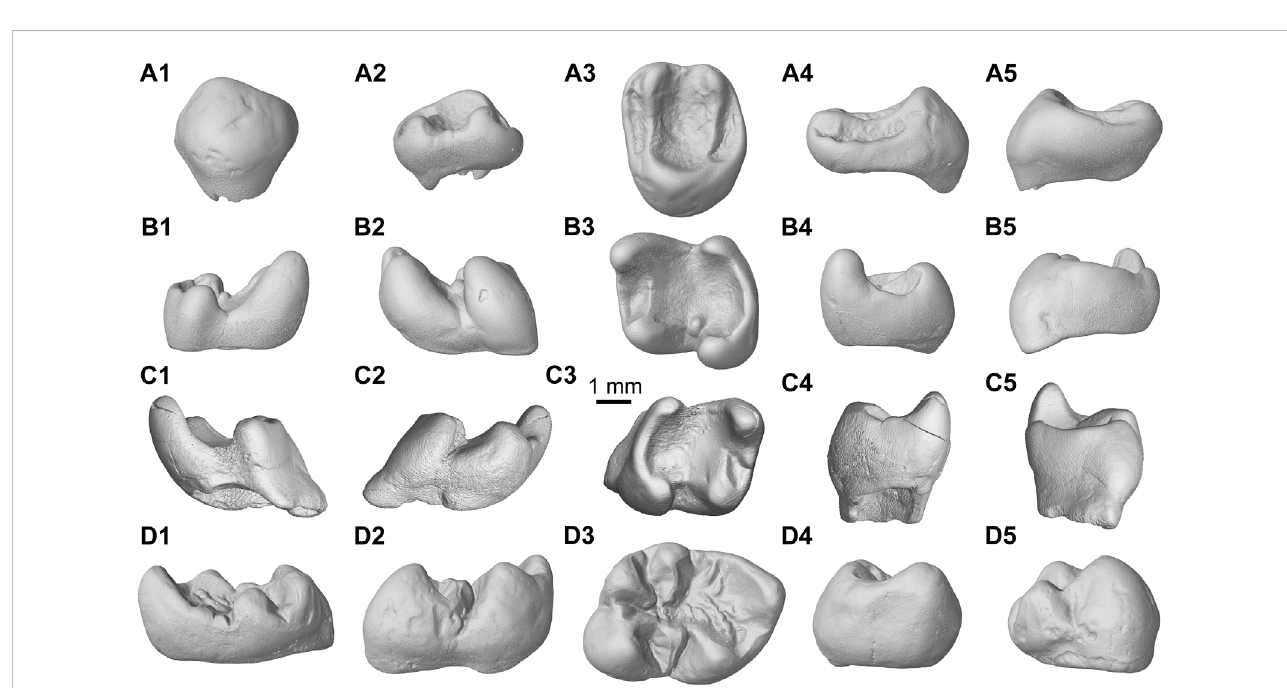
FIGURE 3 3D virtual reconstruction of the molars of Junggarisciurus jeminaiensis gen. et. sp. nov. and Eopetes irtyshensis gen. et. sp. nov. (A1 – A5) IVPP V23185, holotype of J. jeminaiensis , left M1/2; (B1 – B5) IVPP V23186, left m1/2; (C1 – C5) IVPP V23280, paratype, right m1/2; (D1 – D5) IVPP V31378, holotype of E. irtyshensis , right m1/2.1, lingual view; 2, buccal view; 3, occlusal view; 4, anterior view; 5, posterior view. All in the same scale (bar equals 1